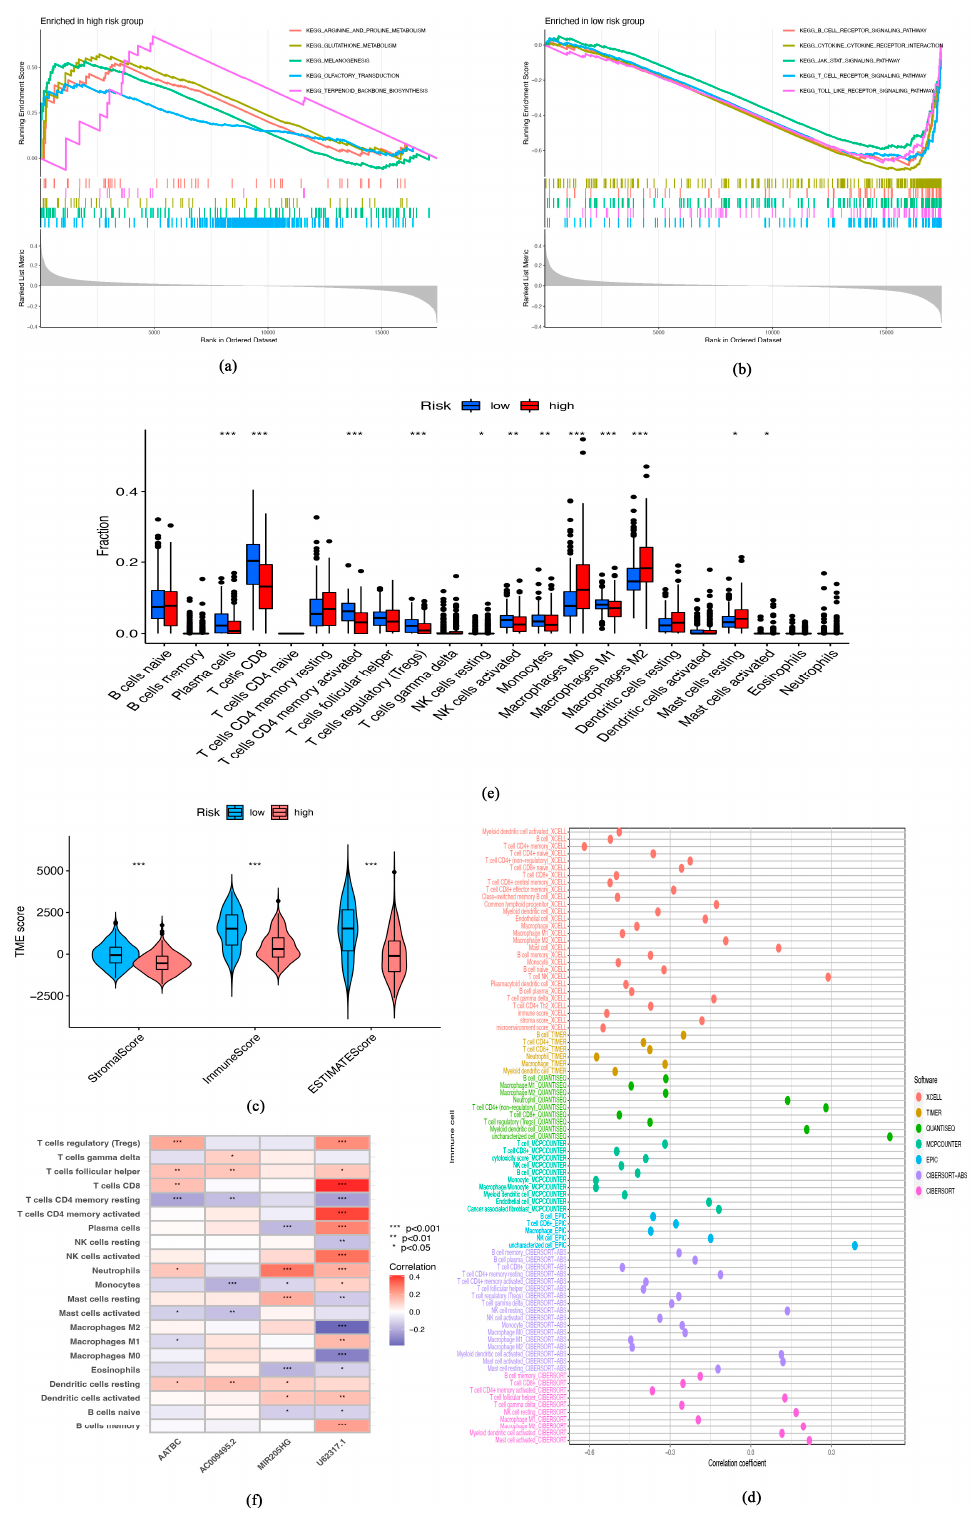
Figure 5. Immune characteristics of senescence-related lncRNA signature. ( a , b ) Gene set enrichment analysis between both risk groups. ( c ) Violin plot that demonstrated immune scores and stromal scores and that estimated scores for different risk groups in the Cancer Genoma Atlas (TCGA) cohort. ( d ) The infiltration of immune cells was calculated by seven immune algorithms. ( e ) The results calculated by the “Cibersort” algorithm. ( f ) The correlation between immune cells and the expression of signature lncRNA. * p < 0.05; ** p < 0.01; *** p <